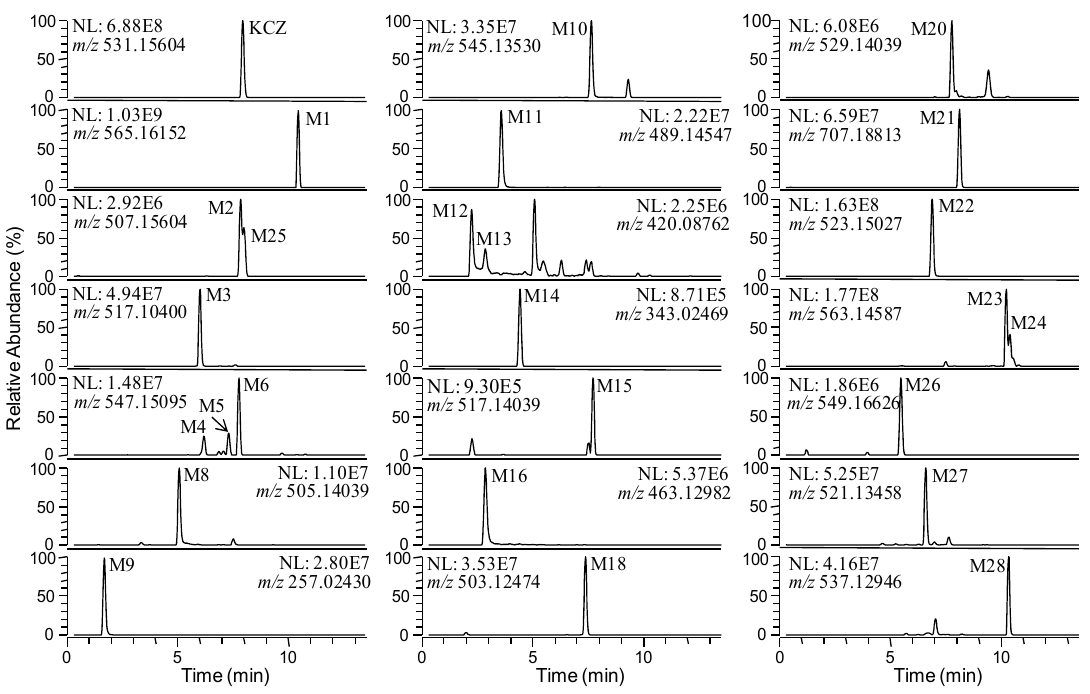
Figure 4. Multivariate data analysis of ketoconazole metabolites in mouse feces. ( A ) Score plot; and ( B ) loading S-plot generated by orthogonal partial least squares discriminant analysis (OPLS-DA). Top-ranking ions were highlighted with dotted ellipse.